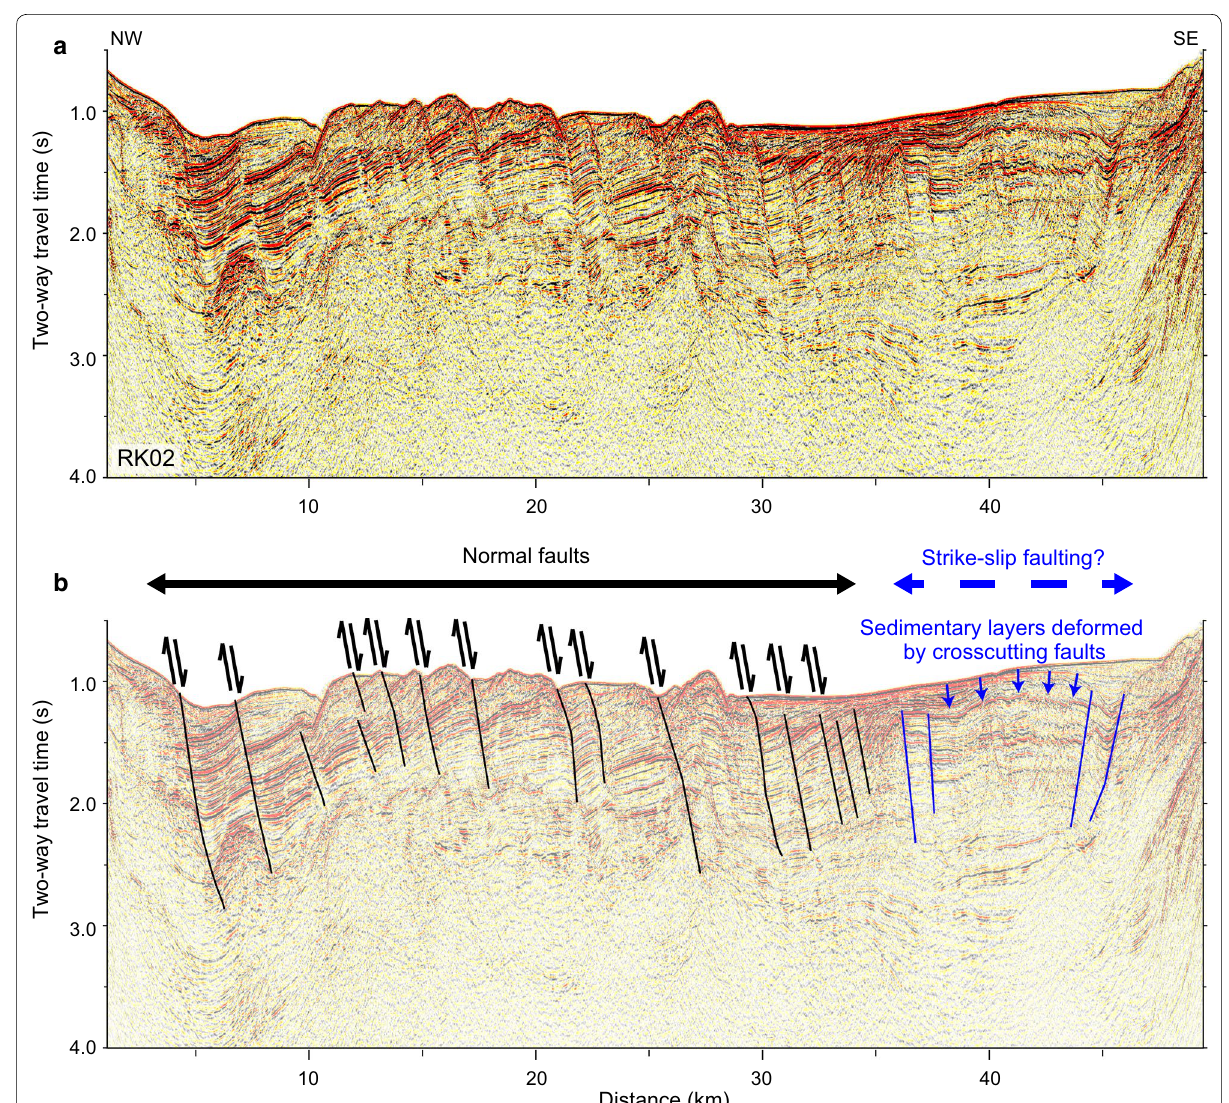
Fig. 8 a Seismic reflection images of the back-arc basin along the RK02 profile and b its interpretation. In this image, normal faults are densely developed at 1–3-km intervals on the western part of the basin (black lines). In most cases, displacements along the faults reach the seafloor and form half-graben structures, suggesting these faults are young or still active. The normal faults consistently dip eastward and produce rotated blocks, indicating an asymmetric rifting style in the basin (see text for discussions). On the eastern part of the basin, the sedimentary layers are highly deformed by crosscutting faults (blue lines and